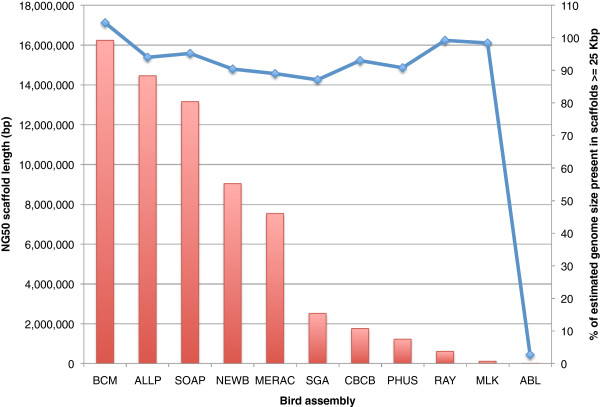
NG50 scaffold length distribution in bird assemblies and the fraction of the bird genome represented by gene-sized scaffolds. Primary Y-axis (red) shows NG50 scaffold length for bird assemblies: the scaffold length that captures 50% of the estimated genome size (~1.2 Gbp). Secondary Y-axis (blue) shows percentage of estimated genome size that is represented by scaffolds ≥25 Kbp (the average length of a vertebrate gene).